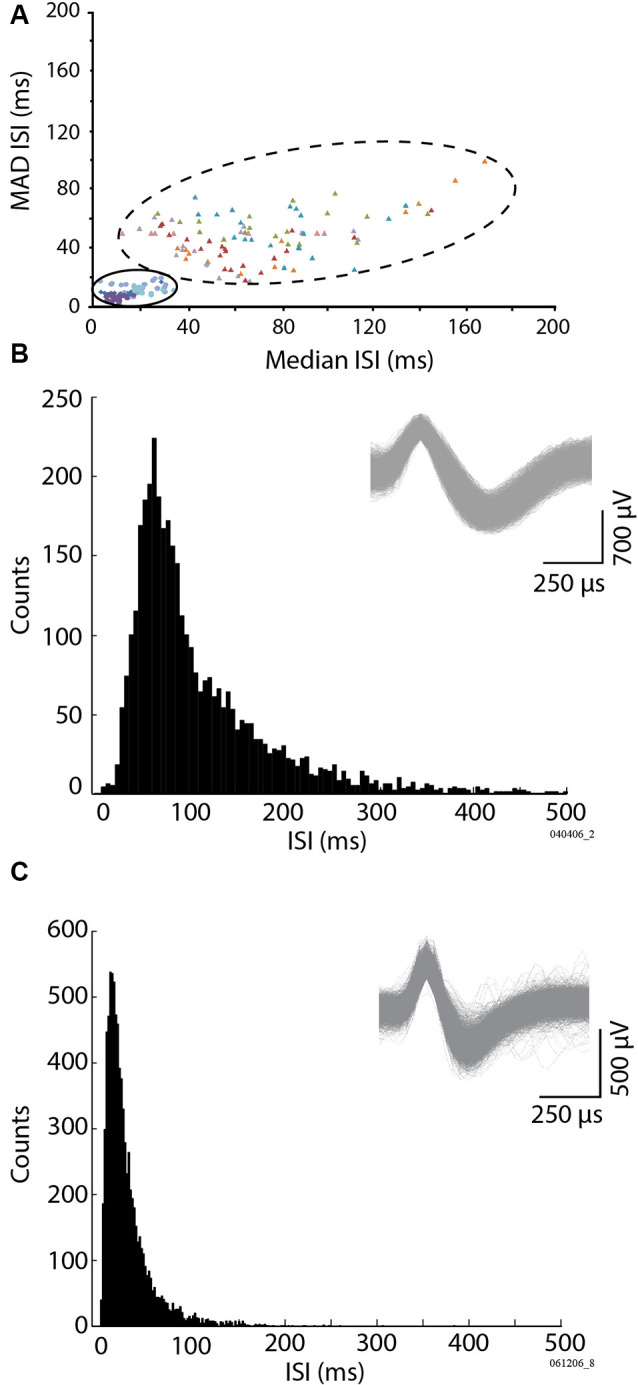
Identification of the Golgi cells vs. Purkinje cell simple spikes (SSs), based on the firing properties. The method follows the one used by Vos et al. (1999), based on the variability of the cell firing (MAD ISI) vs. its median firing values (Median ISI). (A) Representation of two subpopulations of units, Golgi cell units (large ensemble, filled triangles, six cells, colors identify different units), and Purkinje cell SSs (small ensemble, filled circles, and diamonds, four cells), by the relationship between their median inter-spike interval (Median ISI), and the absolute deviation of their median firing inter-spike interval (MAD ISI). (B) Inter-spike interval of a representative identified Golgi cell. (C) Inter-spike interval of a representative Purkinje cell SS. (B,C) Insets: example spike waveforms for a Golgi cell (B) and a Purkinje cell SS (C).